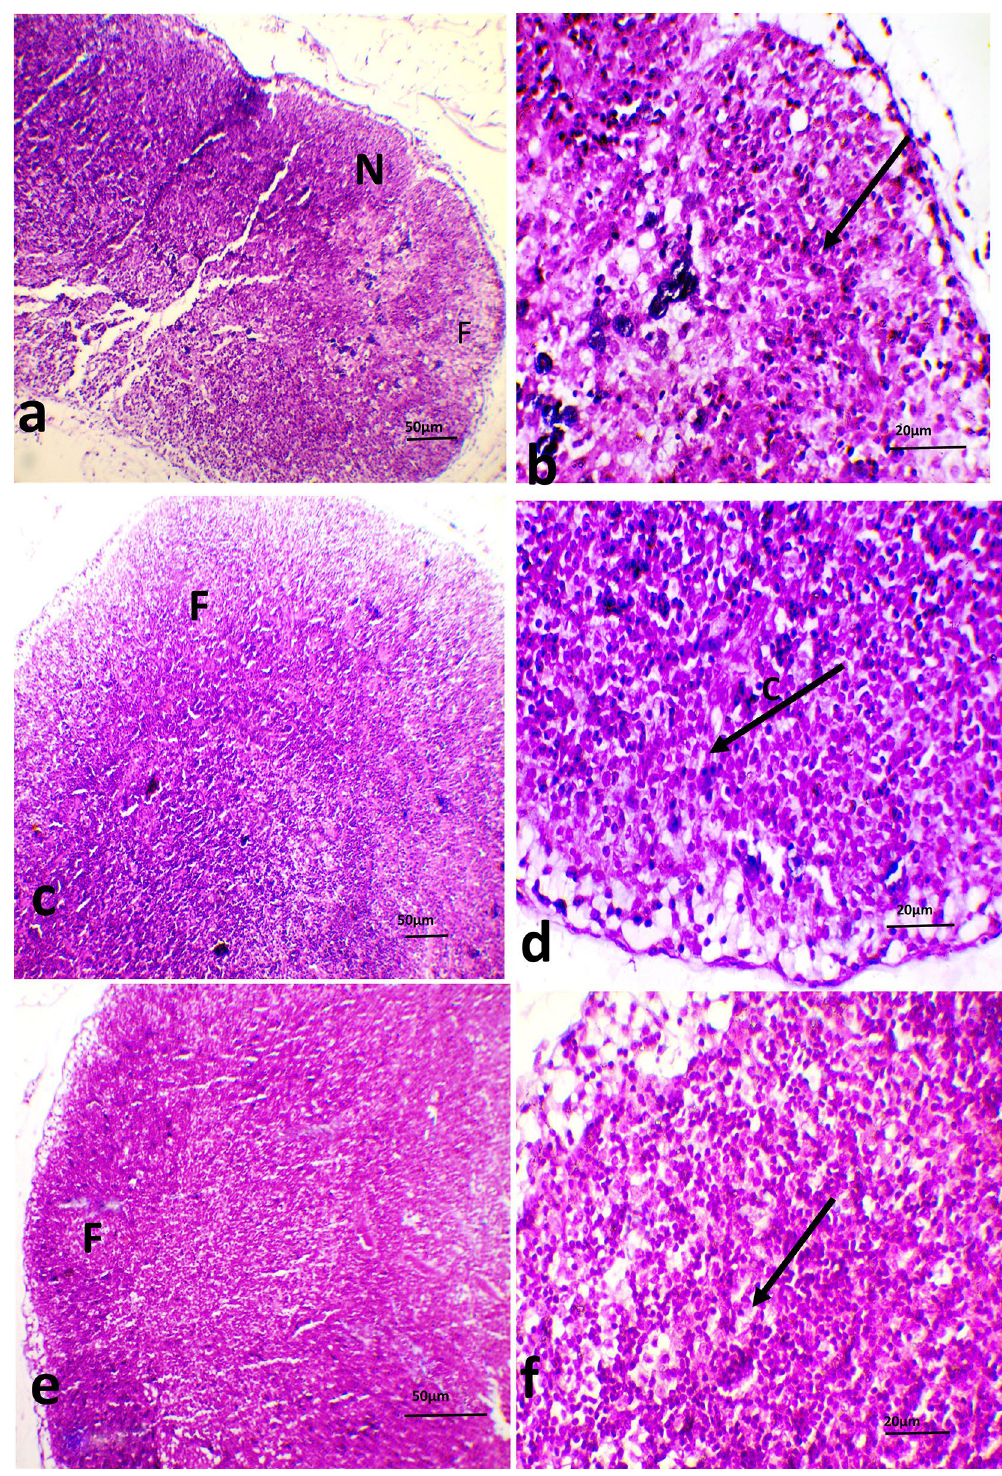
Figure 4. Photomicrograph of popliteal lymph nodes. ( a & b ) The popliteal lymph nodes from a control rat show severe degeneration with a mild necrotic area (N) and a slight increase in the number of lymphocytes (arrow). ( c & d ) The popliteal lymph nodes from a rat belonging to the Sa30 group showed lymphoid follicles ( f ) with germinal centers and a slight increase in the number of lymphocytes (arrow). ( e & f ) The popliteal lymph nodes of a rat belonging to the Sa50 group showed parafollicular hyperplasia ( f ) and a slight increase in the number of lymphocytes (arrow) (H&E stain, ×5 and ×10